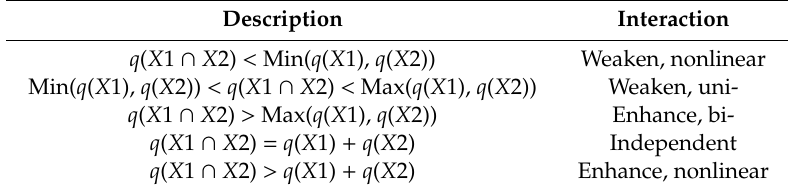
Table 2. Definition of the interaction relationships in geographical detector model